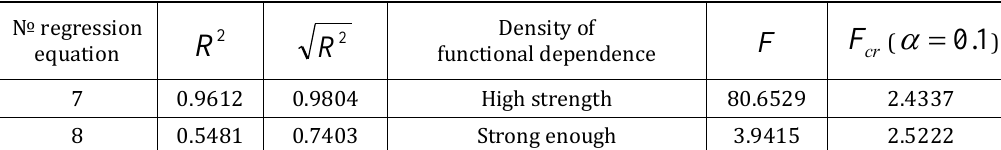
Table 5. Analysis of the adequacy of the proposed mathematical models